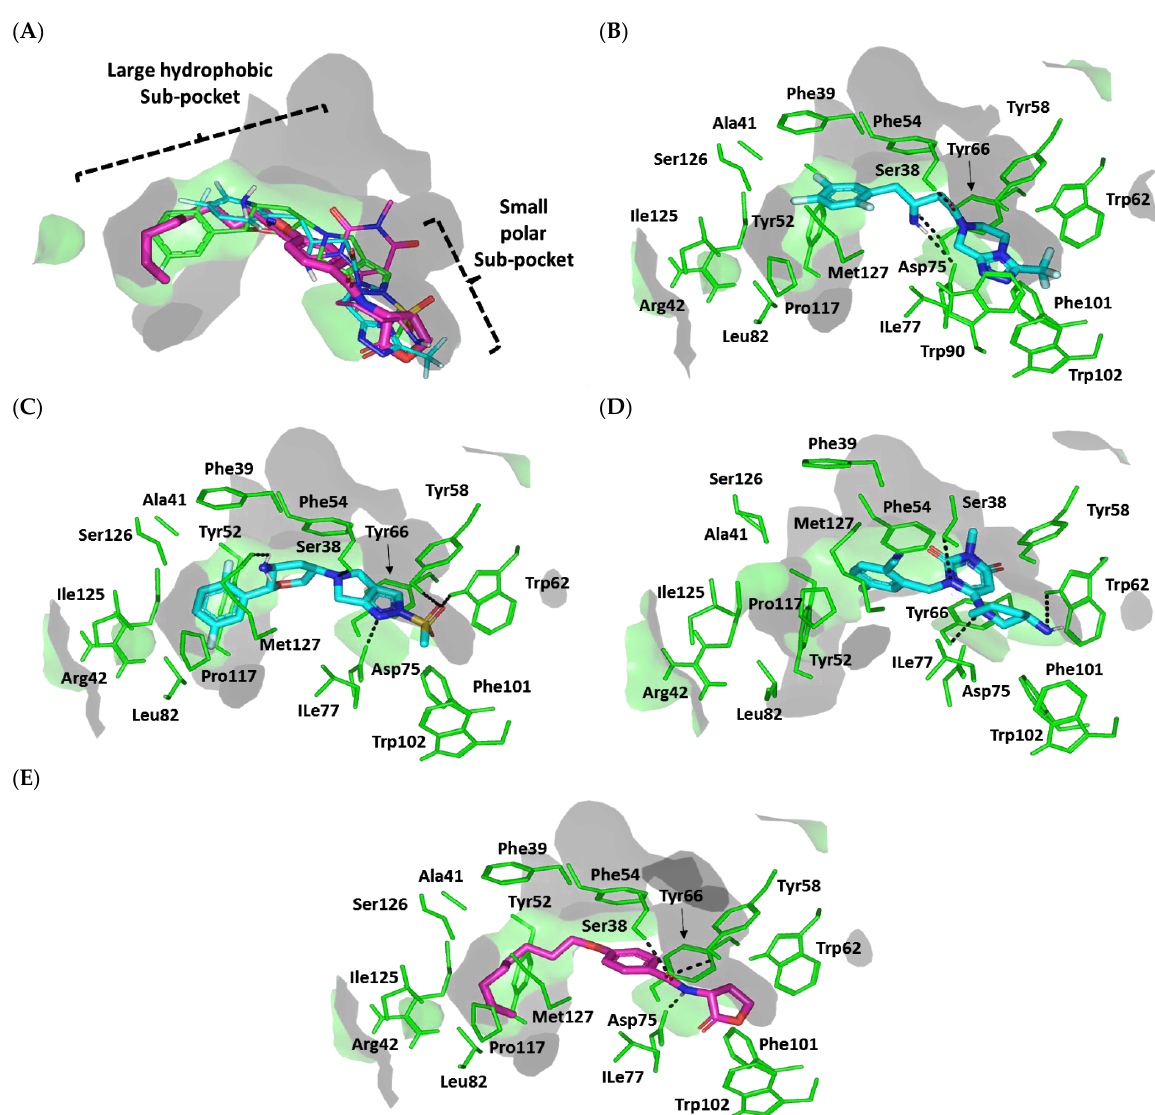
Figure 8. Ligand – protein binding interactions at P. aeruginosa QscR quorum-sensing transcription protein binding site. ( A ) Overlay of investigated compounds (SIT, OMR, and TRG as cyan, green, and purple lines, respectively) and Q9 (magenta sticks) binding to the protein’s canonical binding site comprising small polar head and larger hydrophobic subpockets. ( B – E) Predicted binding modes of the docked ligands (cyan or magenta sticks): ( B ) SIT, ( C ) OMR, ( D ) TRG, and ( E ) Q9. Only amino acids located within 5 Å radius distance from the bound ligand are displayed and labeled with sequence numbers. Non-polar hydrogen atoms are hidden for clarity. Hydrogen bonding is depicted as black dashed